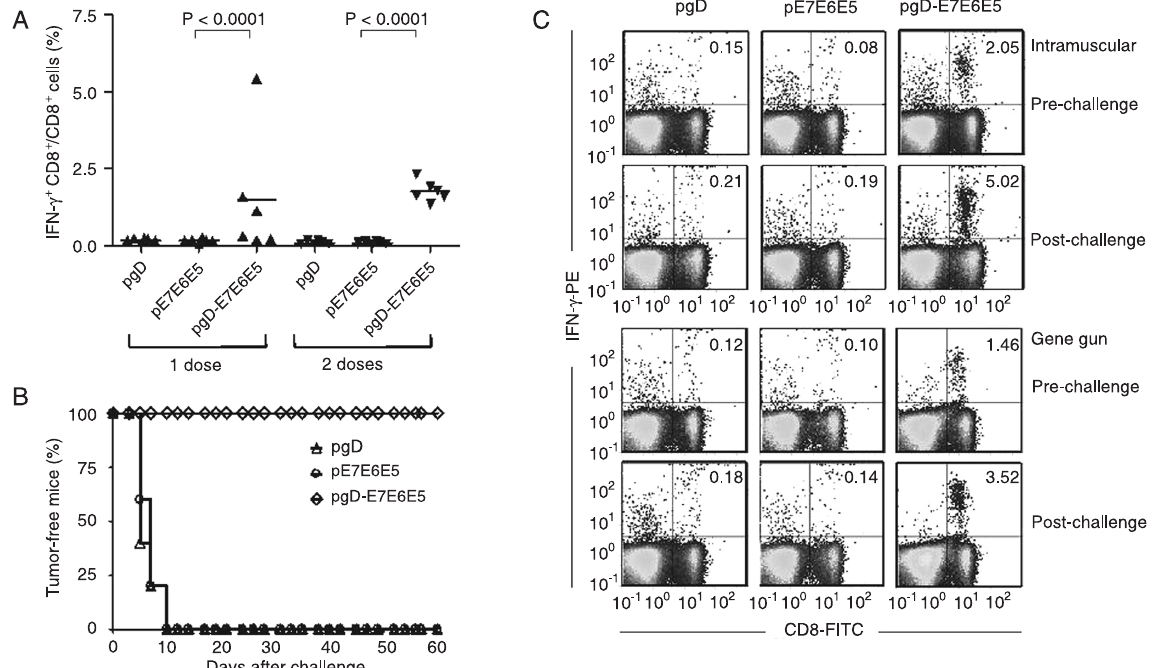
Figure 1. Induction of E7-specific, IFN-γ-producing CD8 + T cell precursors and preventive anti-tumor effects in mice immunized id with the pgD-E7E6E5 vaccine. E7-specific CD8 + T cells were detected with PBMCs incubated with the synthetic MHC class I-restricted E7 peptide ( 49 RAHYNIVTF 57 ) and stained for the CD8 marker (FITC) and accumulated intracellular IFN-γ (PE). A , Individual CD8 + T cell responses in mice immunized with one or two doses of pgD, pE7E6E5 or pgD-E7E6E5 delivered with a gene gun (2 µg/dose). The number of E7-specific CD8 + T cells was determined 2 weeks after the last vaccine dose. B , Mice immunized with one id dose of pgD-E7E6E5, pE7E6E5, or pgD were challenged with 5.10 5 TC-1 tumor cells 2 weeks after the last vaccine dose. Tumor growth was followed up to 60 days after inoculation of the TC-1 cells. C , Mice were immunized with one dose of pgD-E7E6E5, pE7E6E5, or pgD delivered via the id or im route, and the frequencies of E7-specific CD8 + T cells were determined 2 weeks after the last immunization (pre-challenge) and 2 weeks after the TC-1 challenge (post-challenge) in pooled PBMCs. The numbers at the right upper corners represent the frequencies of E7-specific CD8 + T cells as a percentage of IFN-γ-producing CD8 + T cells of the total detected CD8 + T cells. IFN-γ = interferon-γ; PE = phycoerythrin; FITC = fluorescein isothiocyanate; PBMCs = peripheral blood mononuclear cells. Sta- tistically significant differences (P < 0.001) were noted with regard to mice immunized with pgD or pE7E6E5 control vectors (ANOVA and Turkey